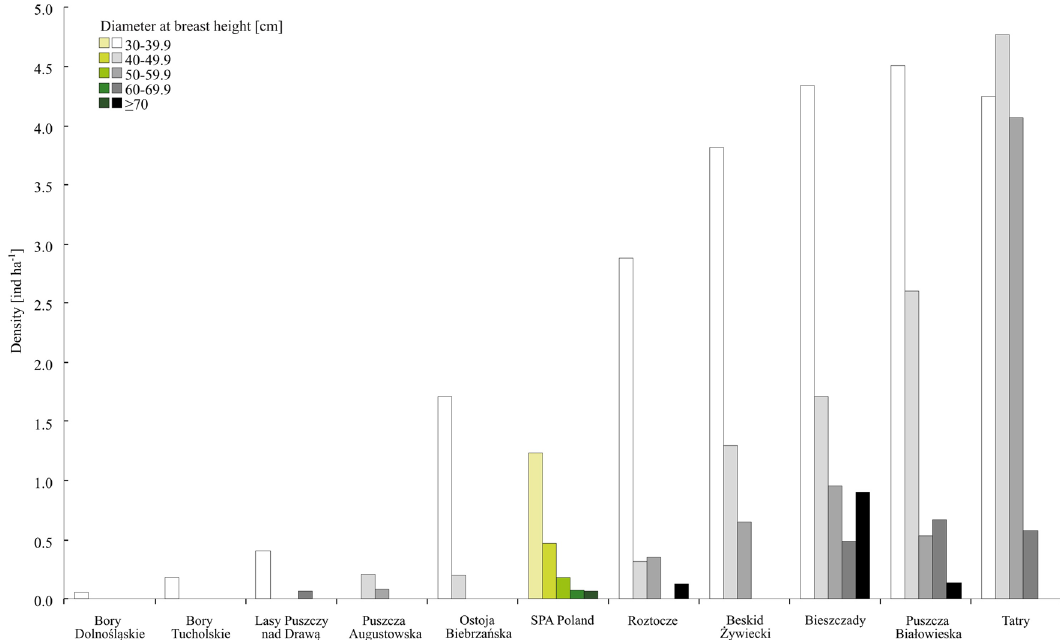
Figure 5. Structure of standing deadwood with DBH ≥ 30 cm for SPA Poland and 10 of the selected SPAs.